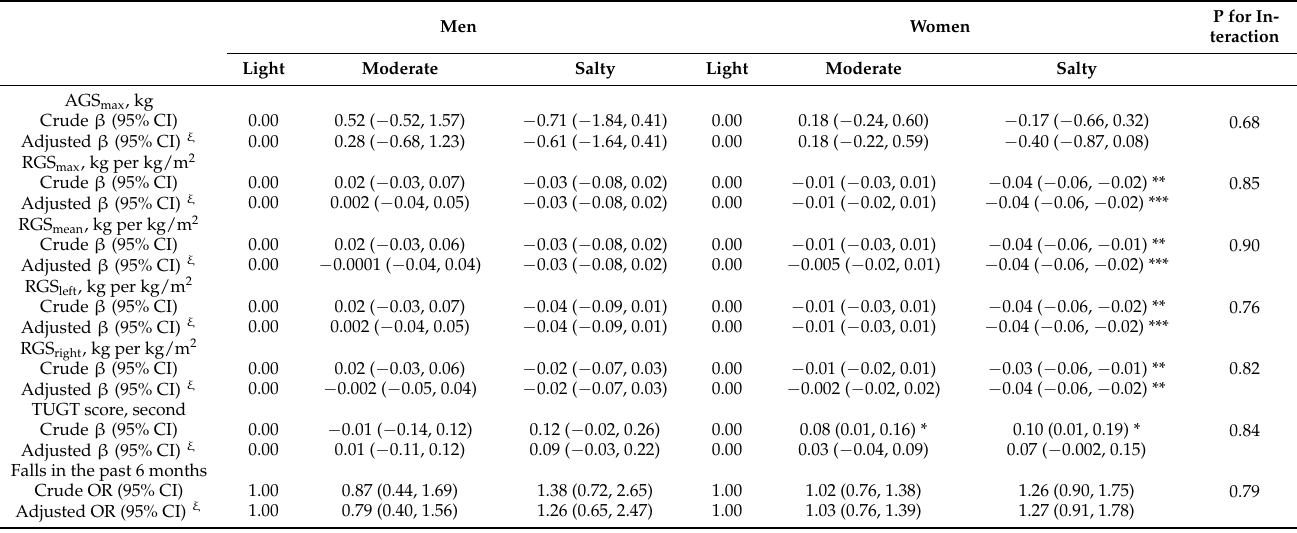
Figure 3. Association of salt intake with falls in the past 6 months on 4867 participants of the Guangzhou Biobank Cohort Study. OR = odds ratio, CI = confidence interval. † Adjusted OR (95% CI): adjusted for sex, age, education, family income, occupation, physical activity, smoking status, alcohol use, body mass index (BMI), self-rated health, and self-reported hypertension. Table 2. Associations of general salt intake with grip strength, timed up-and-go test, and falls in 1351 men and 3516 women of the Guangzhou Biobank Cohort Study.